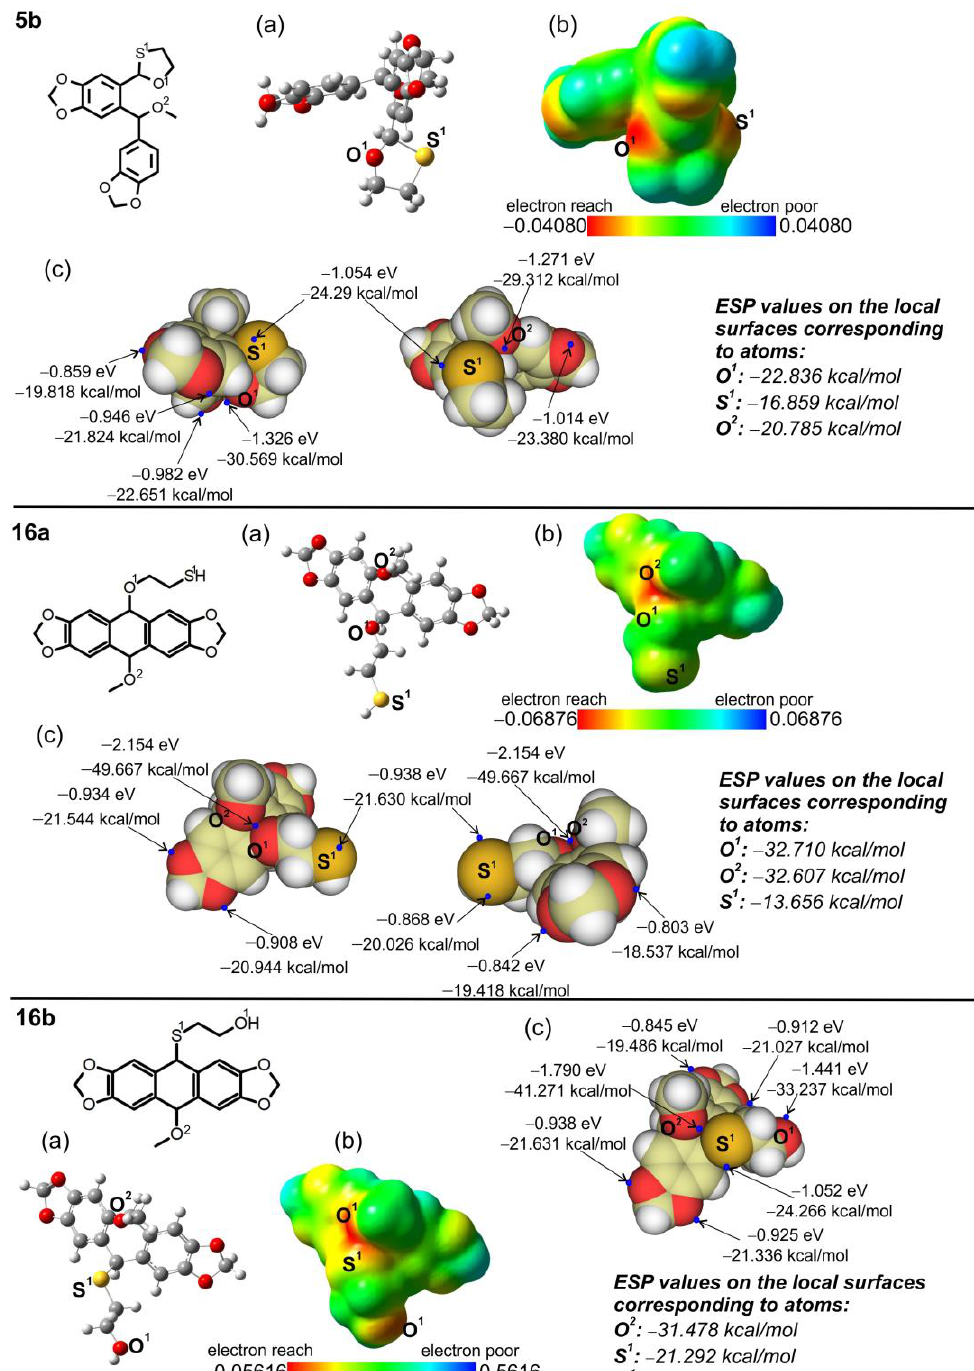
Figure 4. ( a ) Molecular structures of 5b , 16a and 16b optimized at the DFT theory B3LYP/6- 311++G(d,p) (see also Tables S3 – S5 in Supplementary Materials), ( b ) electron density maps from total SCF B3LYP mapped with ESP (isovalue = 0.02; blue corresponds to low electron densities, whereas red corresponds to high electron densities), ( c ) the largest minima of ESP (blue points) on the van der Waals surfaces and the ESP values on the local surfaces corresponding to O 1 , O 2 and O 3 atoms (italic).